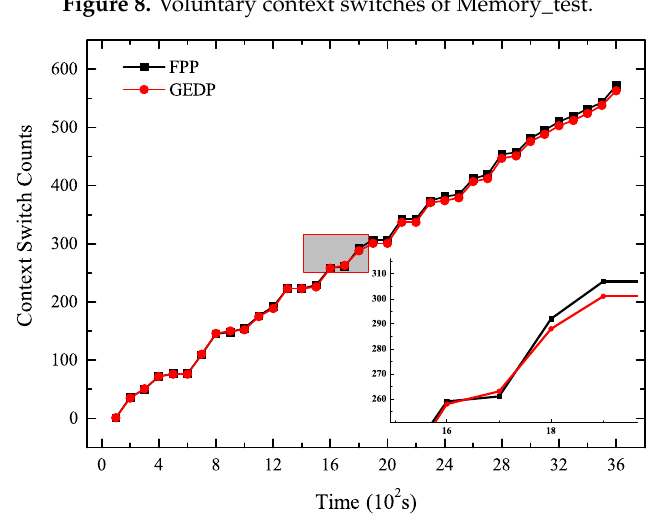
Figure 8. Voluntary context switches of Memory_test.